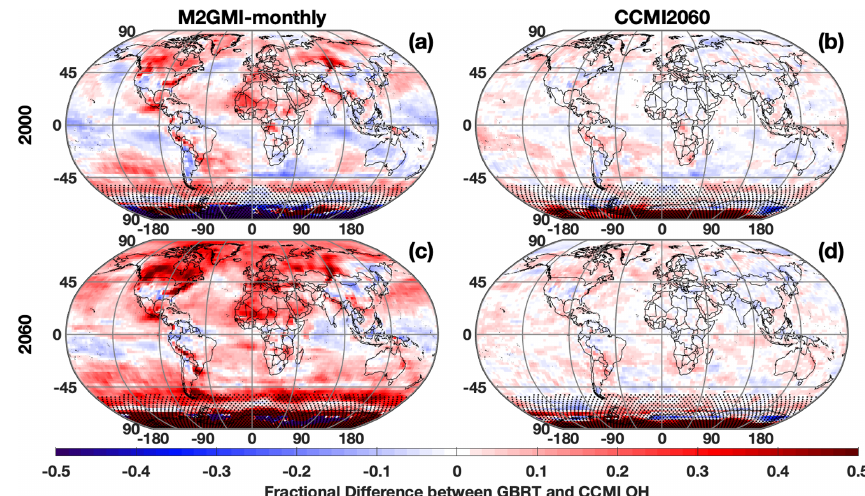
Figure 11. Fractional difference between OH calculated by the M2GMI-monthly (a, c) and the CCMI2060 (b, d) parameterizations and OH output from the CCMI simulation. Data are averaged between 850 and 500hPa for July 2000 (a, b) and July 2060 (c, d) . Regions with low OH, defined as a mixing ratio of less than 0.005pptv, are indicated with stippling.